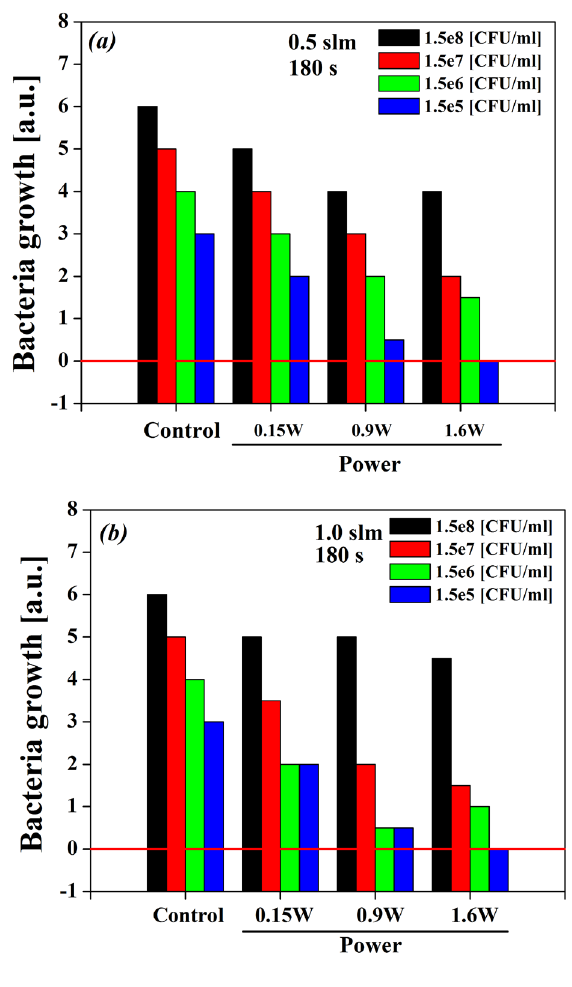
Figure 4: Sterilization of Enterococcus faecalis ATCC 29212. The samples contained four different concentrations of bacteria. The untreated control values for bacterial growth are 6(1.5×10 8 CFU mL -1 ), 5(1.5×10 7 CFU mL -1 ), 4(1.5×10 6 CFU mL -1 ) and 3(1.5×10 5 CFU mL -1 ). Treatment time was 180 s. (a) He flow 0.5 sLm; (b) He flow 1 sLm. The red line represents complete sterilization of the sample.